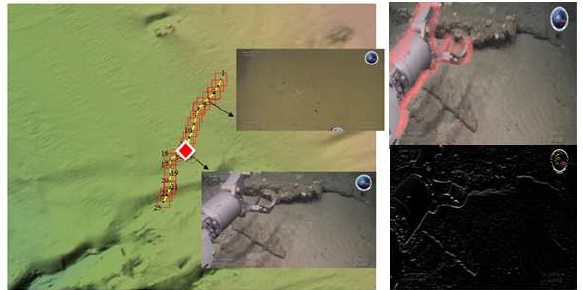
Figure 11. Images of some of de projects developed. 1 and 2 on the left. 5 and 6 on the right.